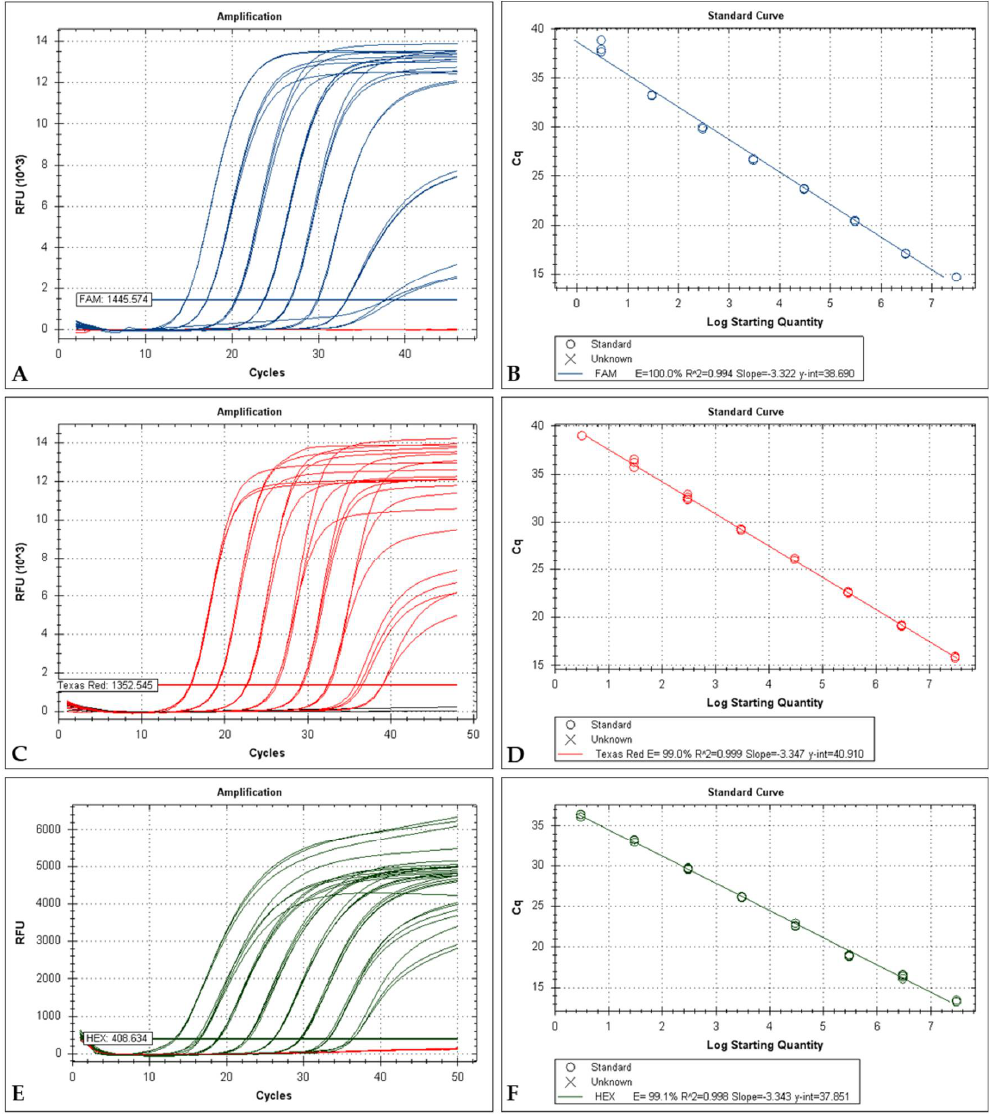
Figure 1. ( A ) Serial dilution from 3.0 × 10 7 to 3.0 × 10 0 copies of m000.5L/R per reaction. Red lines correspond to negative controls (3.0 × 10 −1 copies). ( B ) Standard curve for the m000.5L/R qPCR, the log starting quantity ranged from 3.0 × 10 7 to 3.0 × 10 0 copies in the final reaction. ( C ) Serial dilution from 3.0 × 10 7 to 3.0 × 10 0 copies of m060L per reaction. Black lines correspond to negative controls (3.0 × 10 −1 copies) ( D ) Standard curve for the m060L qPCR, the log starting quantity ranged from 3.0 × 10 7 to 3.0 × 10 0 copies in the final reaction. ( E ) Serial dilution from 3.0 × 10 7 to 3.0 × 10 0 copies of m009L per reaction. Red lines correspond to negative controls (3.010 −1 copies). ( F ) Standard curve for the m009L qPCR, the log starting quantity ranged from 3.0 × 10 7 to 3.0 × 10 0 copies in the final reaction.